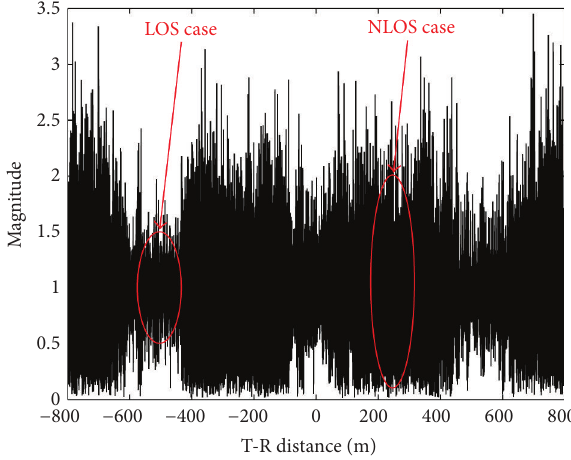
Figure 3: Measurement envelope. Figure 4: The 𝐾 -factor against T-R distance.